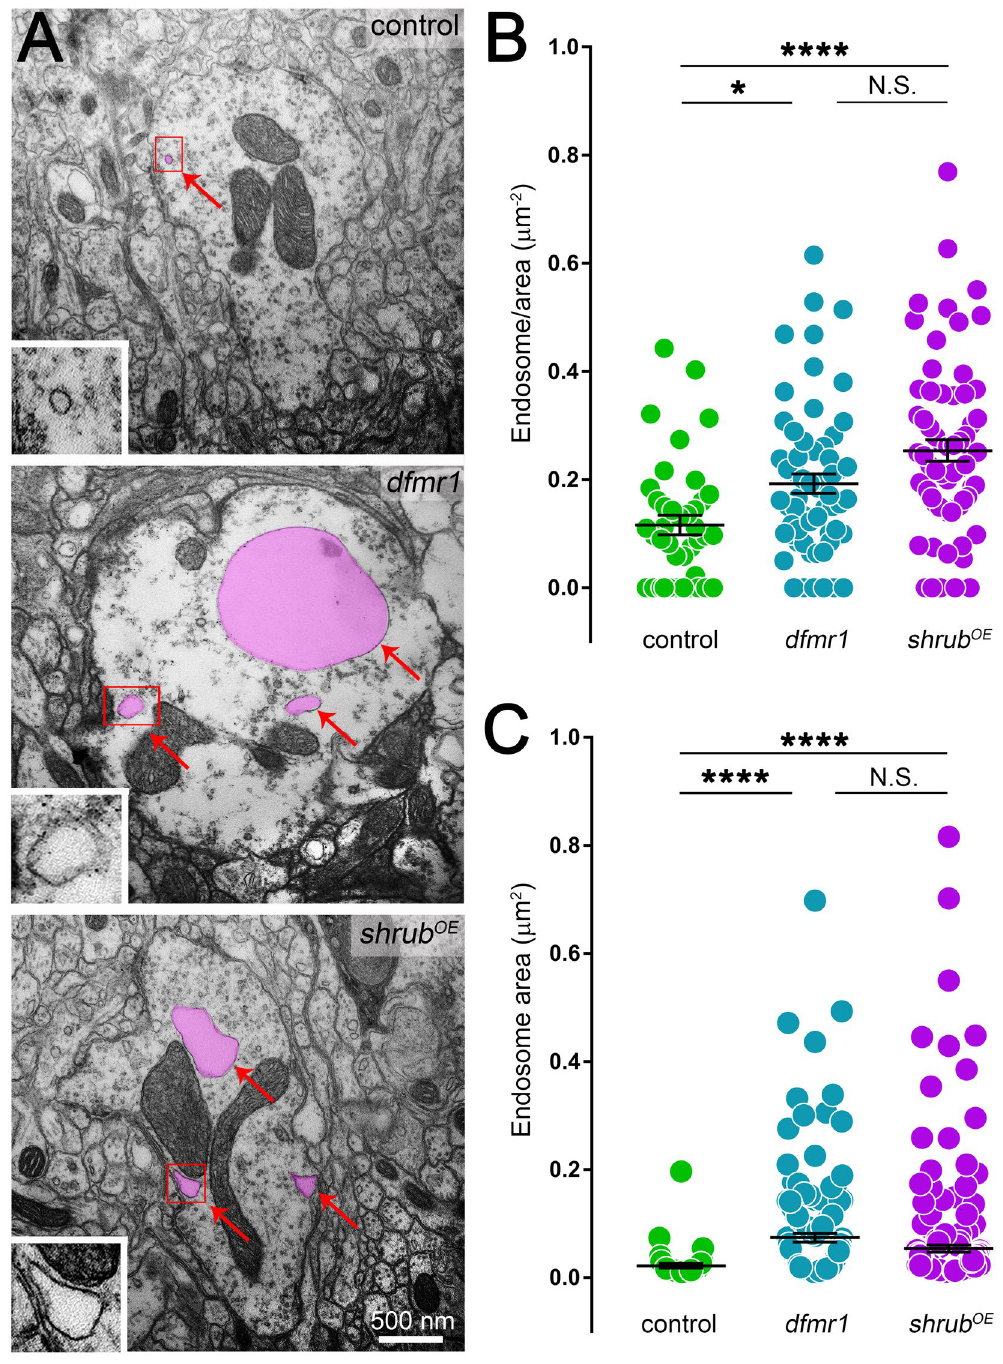
Figure 5. FMRP LOF and Shrub GOF similarly increase PN synaptic endosomic vacuoles. ( A ) Representative electron micrographs of projection neuron synaptic boutons in the MB calyx comparing transgenic control ( elav -Gal4/ + ), dfmr1 null mutant ( elav -Gal4/ + ; dfmr1 50M ) and shrub over-expression ( shrub OE ) GOF ( elav - Gal4/ + ; UAS-Shrub/ + ). Typical endosomic vacuole examples are pseudo-colored (magenta), with insets showing enlarged organelle (red box in main image). Dot plot quantification of endosomes per bouton area ( B ) and endosome area ( C ) for all three genotypes, comparing mean ± SEM. Statistics done with one way ANOVA with the Kruskal-Wallis test followed by a Dunn’s multiple comparison test post hoc indicated as N.S. P > 0.05, * P < 0.05 and **** P <